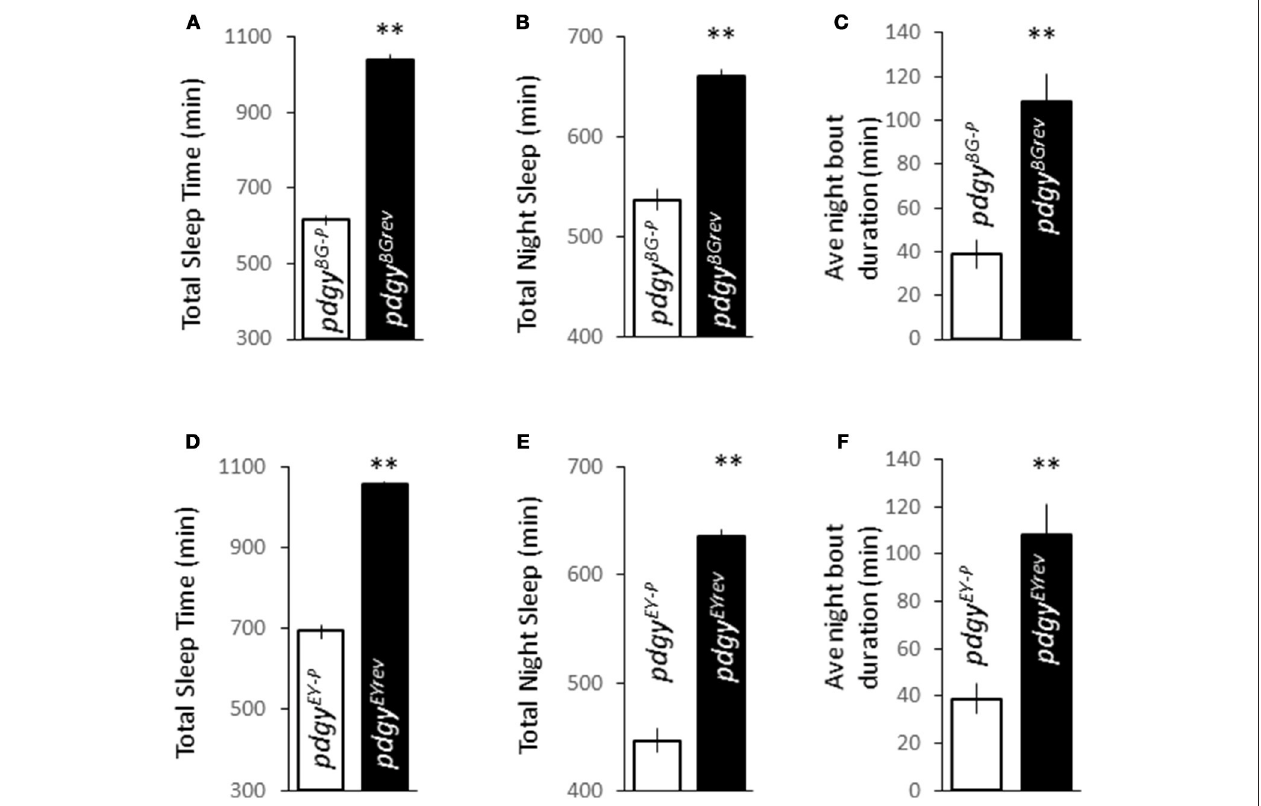
FIGURE 2 | Disruption in pdgy expression alters baseline sleep characteristics. (A–C) Flies with decreased pdgy expression, pdgy BG − P ( n = 84), show reductions in sleep with sleep times over 24h sleep duration throughout the night (B) , (A) and sleep consolidation as measured by average night bout duration (C) compared